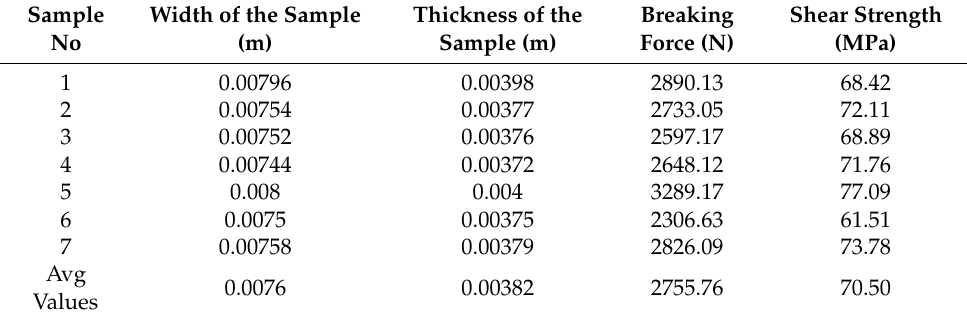
Table 5. Shear strength evaluation of T700 carbon fiber/epoxy